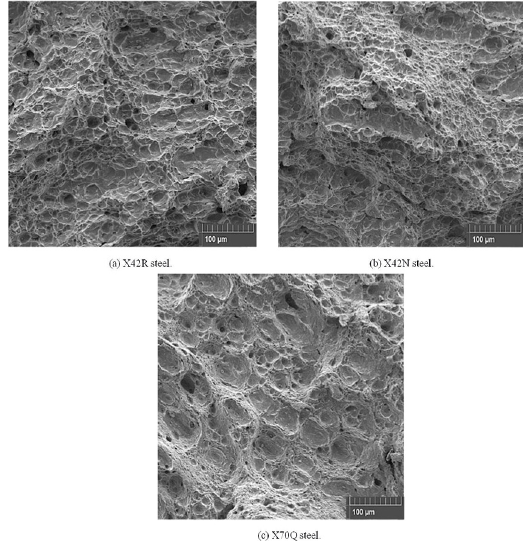
Figure 3. SEM fractographies, J integral test specimens, Δa corresponding to J . Q